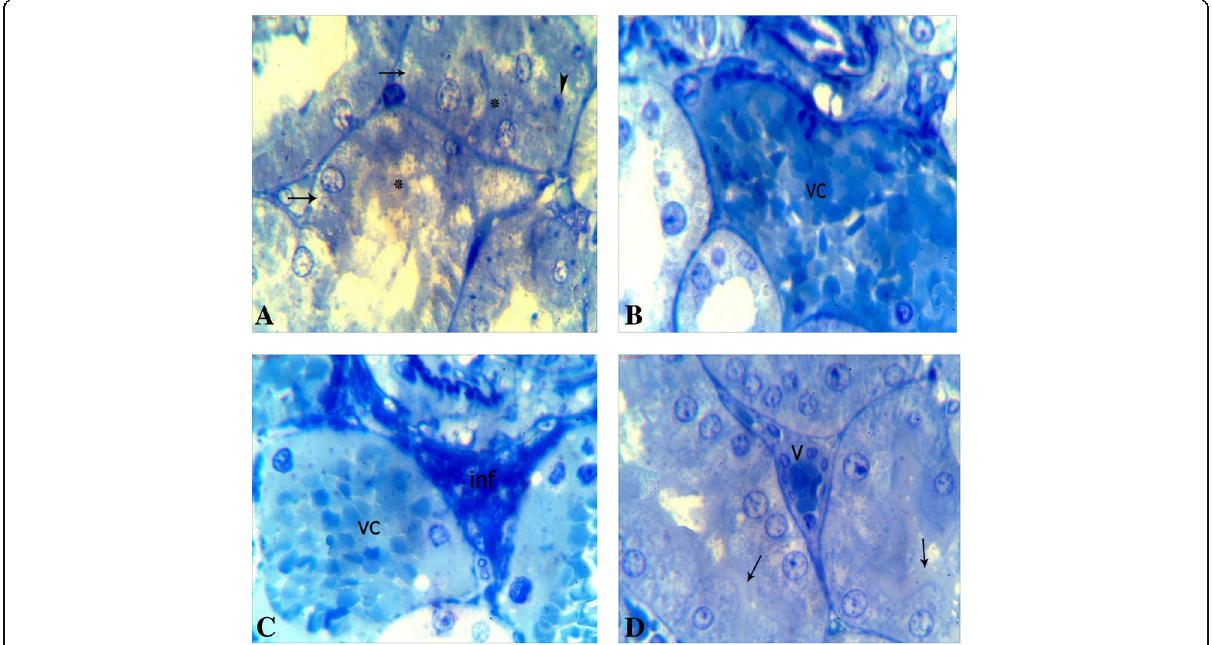
Fig. 4 Photomicrographs of semithin sections of rat kidney tissue. a – c Sections in CA group showing some degenerated epithelial cells of the proximal tubules with a high degree of cytoplasmic vacuolization (thin arrows), destructed of the apical brush border (asterisk), necrosis of some nuclei (arrowhead), as well as a highly vascular congestion (VC) and interstitial infiltration (inf) are present. d The section in CA + FU group showing proximal tubules with mostly intact epithelial lining and brush border (arrows) and a normal appearance of vessels (v). (Toluidine blue. ×